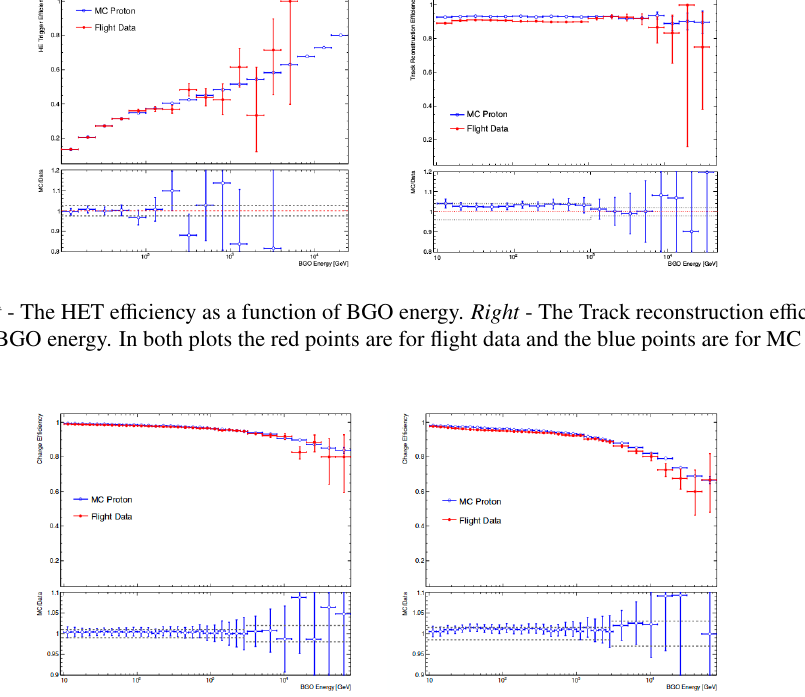
Figure 2. The charge reconstruction e ffi ciency as a function of BGO energy, for PSD layer 1 ( Left ), for PSD layer 2 ( Right ). In both plots the red points are for flight data and the blue points are for MC